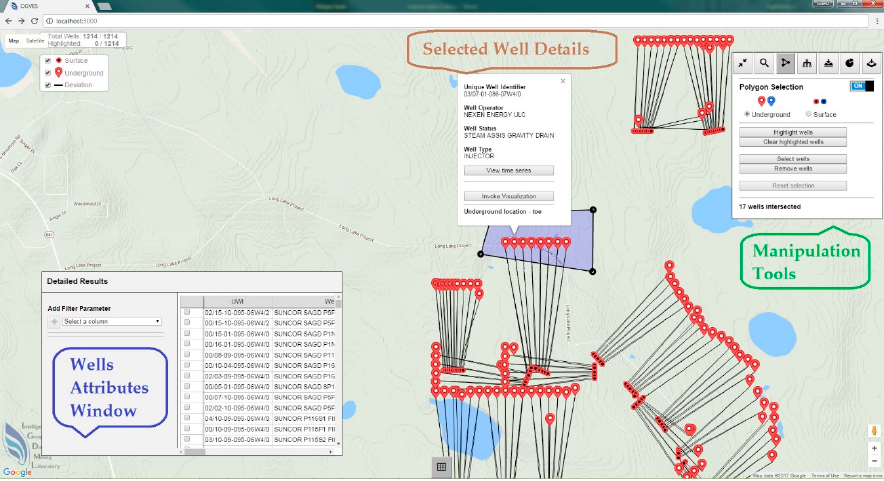
Figure 2. Web-based user interface of OGVES.